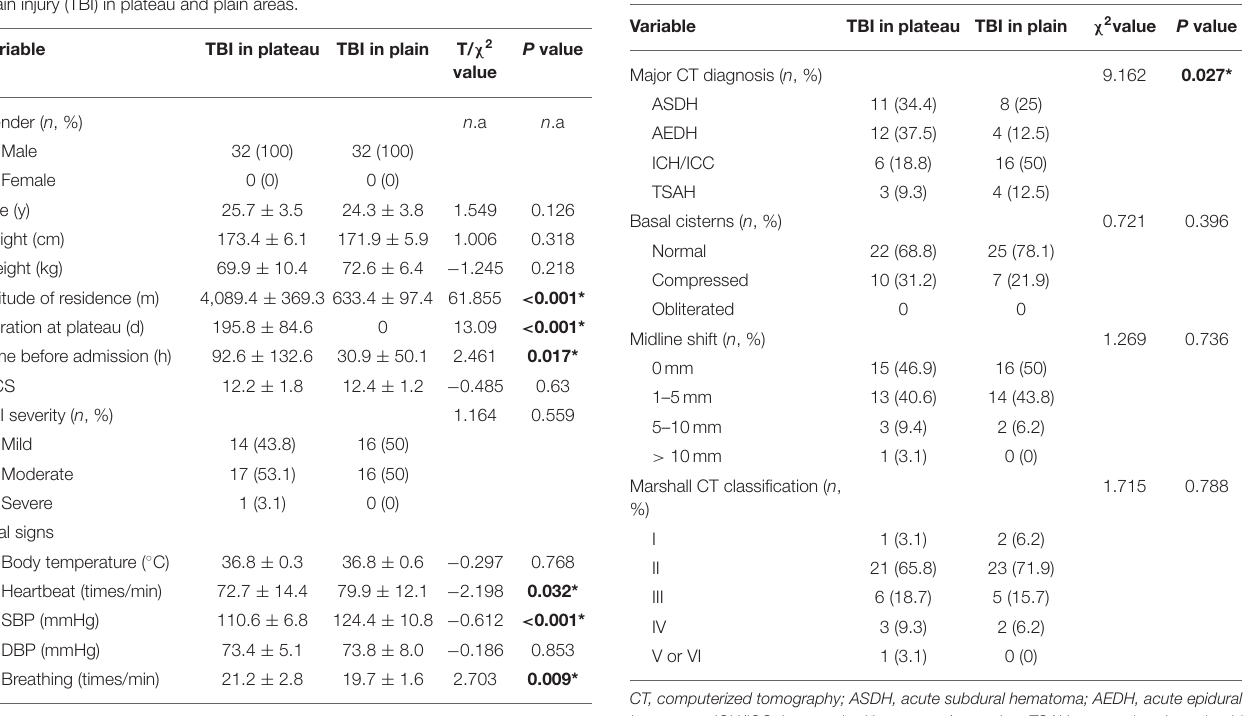
TABLE 2 | Head CT presentations of patients with TBI in plateau and plain